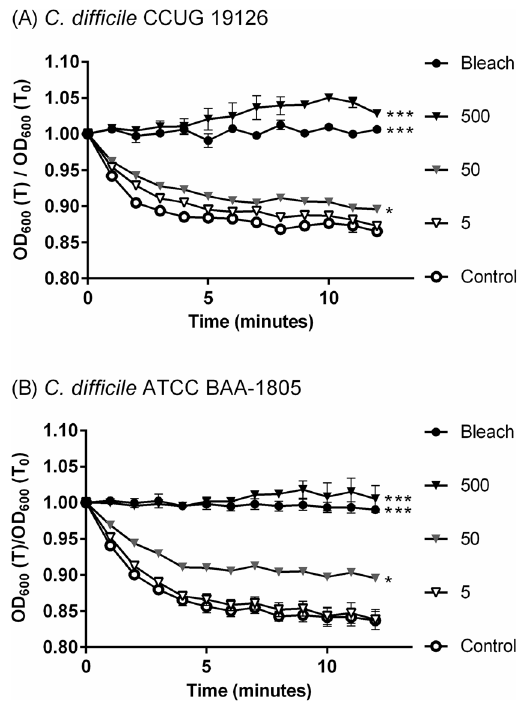
Figure 3. Spore germination was significantly inhibited in Fe 3- δ O 4 -treated pathogenic strains of C . difficile . Spores from two pathogenic strains of C . difficile (CCUG 19126 and ATCC BAA-1805) were treated for 20 minutes with various concentrations of Fe 3- δ O 4 nanoparticles and then with 10 mM taurocholate to induce spore germination. Spore germination was effectively inhibited in the two Fe 3- δ O 4 -treated pathogenic strains, as it was in the nonpathogenic CCUG 37780 strain. ( *** P < 0.001, * P < 0.05; one-way analysis of variance [ANOVA] followed by Tukey’s Multiple Comparison test).